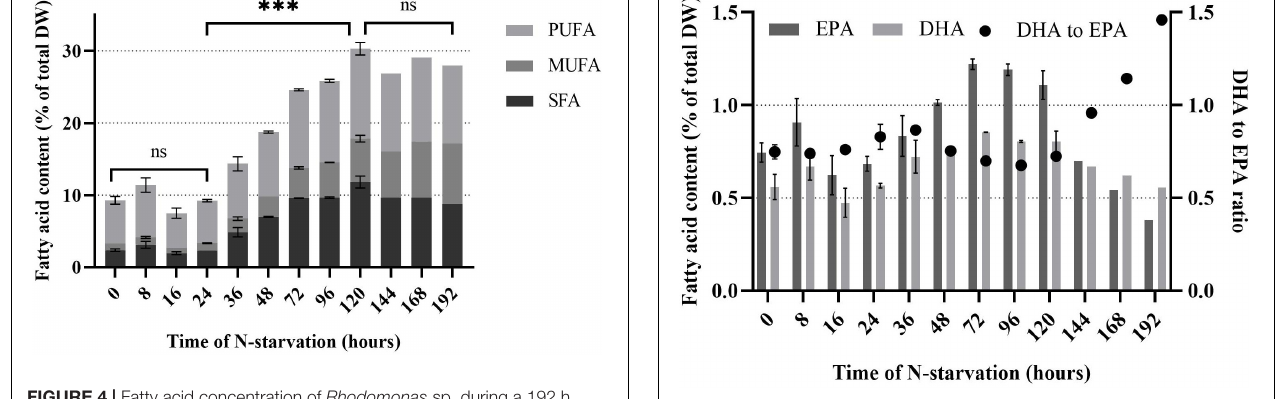
FIGURE 5 | Eicosapentaenoic acid (EPA), docosahexaenoic acid (DHA) and DHA to EPA ratio of Rhodomonas sp. during a 192 h N-starvation period. Data are expressed as the average of three replicates ±